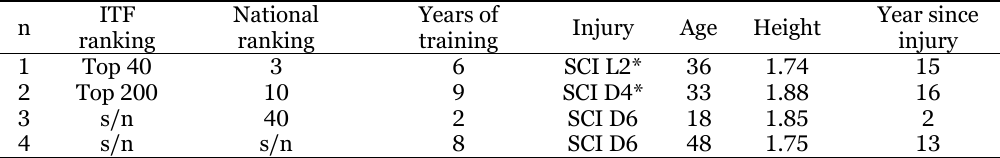
Table 1. Characteristics of the male wheelchair tennis